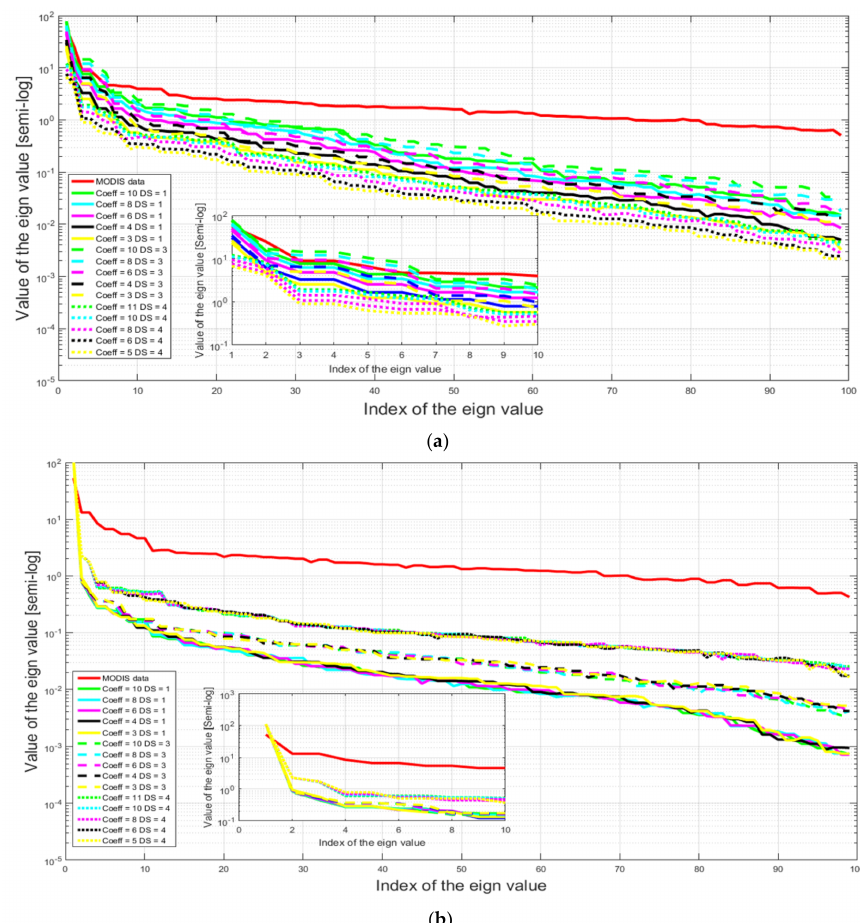
Figure 13. Eigenvalues for ( a ) AOD (top) and ( b ) SSA (bottom) distributions from MODIS and Model’s results using all dust schemes for the dust event of March